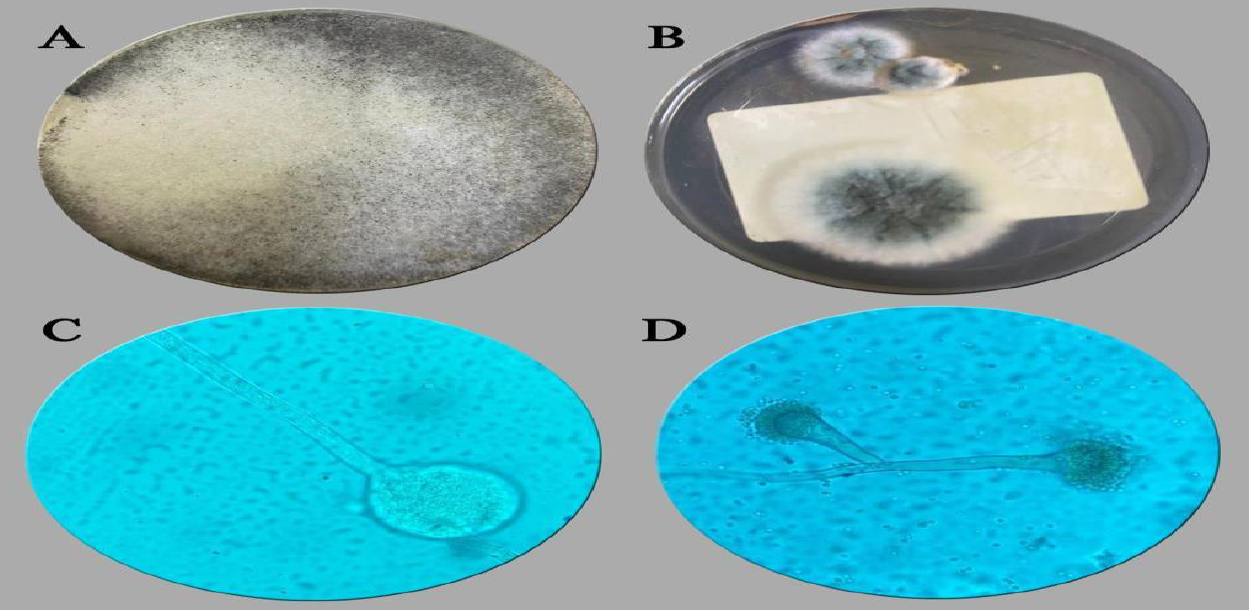
Figure 2. (A): Zygomyces spp on SDA showing showing wooly gray- white colored colonies with black dots. (B): Aspergillus spp on SDA showing granular dark greenish colonies with white margin. (C): Mucor spp with lactophenol cotton blue staining showing thick, non septate hyphae with conidia (magnification, ×40). (D): Aspegillus spp with LPCB staining showing septate hyphae with chains of conidia (magnification, ×40).